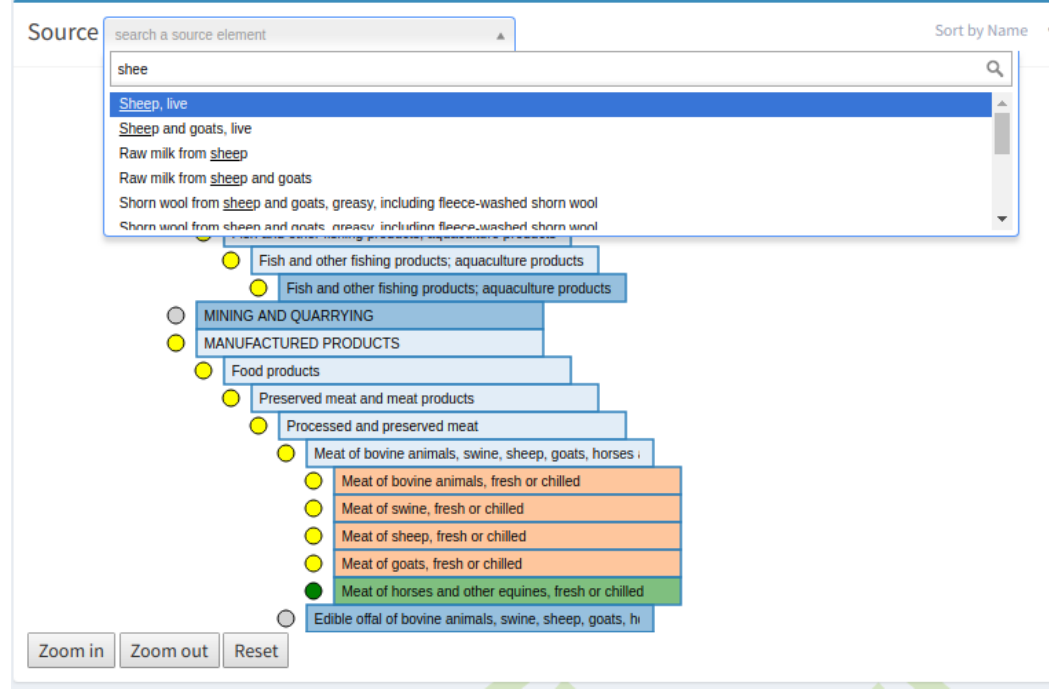
Figure 4. A close up of the Graph